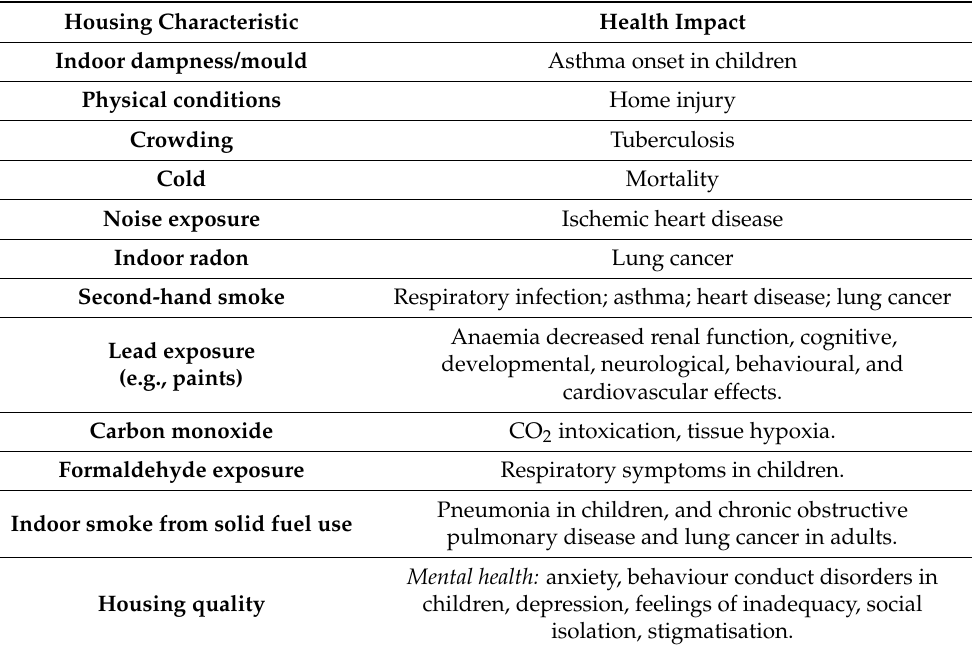
Table 1. Diseases caused by poor quality indoor environments according to the